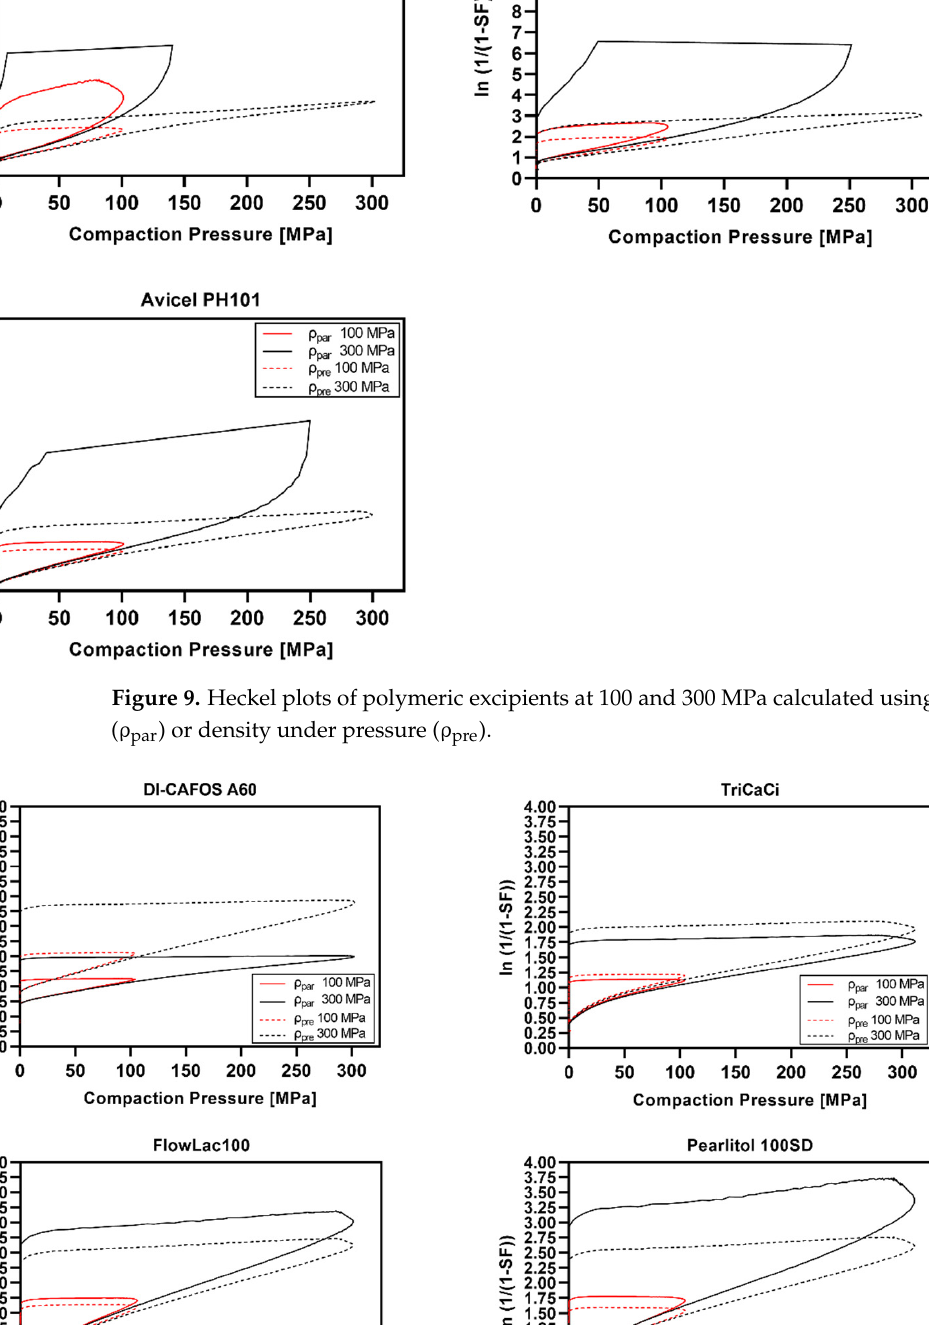
Figure 11. Heckel plots of HME ASD and HME TB at 100 and 300 MPa calculated using particle density (  par ) or density under pressure (  pre ). The calculated results of the Heckel analysis (in ‐ die) are summarized in Table 3 for CP of 100 MPa (CP100) and 300 MPa (CP300) for all excipients as well as HME ASD and HME TB. The calculation of mean yield pressure (PY) allows an interpretation of the start of plastic flow, whereas the SF at intercept A of the linear ascending part of the Heckel plot indicates where SF bonding would occur. The highest mean yield pressures (PY) were observed for the nonpolymeric excipients such as DI CAFOS®A60 ( ρ par: 293 MPa at CP100; 585 MPa at CP300) and TriCaCi ( ρ par: 243 MPa at CP100; 336 MPa at CP300;) as expected for brittle fillers. At CP100 ( ρ par), FlowLac®100 (138 MPa) and Pearlitol®100SD (130 MPa) exhibited values above 100 MPa, indicating a lower degree of brittle defor ‐ mation. In contrast, the polymeric excipients revealed P Y values at CP100 ( ρ par ) below 100 MPa, indicating viscoelastic to plastic compaction behavior (HPMCAS: 42 MPa, So ‐ luplus ® : 57 MPa, copovidone: 80 MPa, Starch1500 ® : 82 MPa). The respective P Y values for HME ASD (79 MPa) and TB (88 MPa) were similar to pure copovidone, as copovidone is a major component of the formulation. Still, slightly higher values at both CPs could be